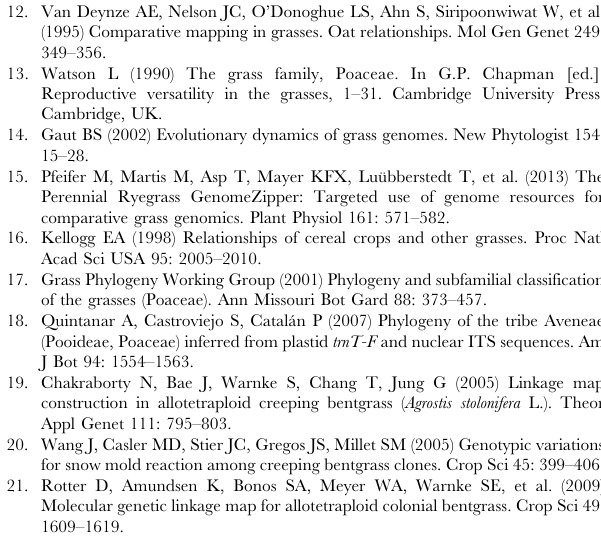
Table S1 Creeping bentgrass cDNA probes mapped on 14 linkage groups of the creeping bentgrass reference population (549 x 372) [ 22 ] . The e -value of the cDNA sequence that matches to database (BLASTX) and the map position of the bentgrass ESTs relative to rice [46] and wheat [47]